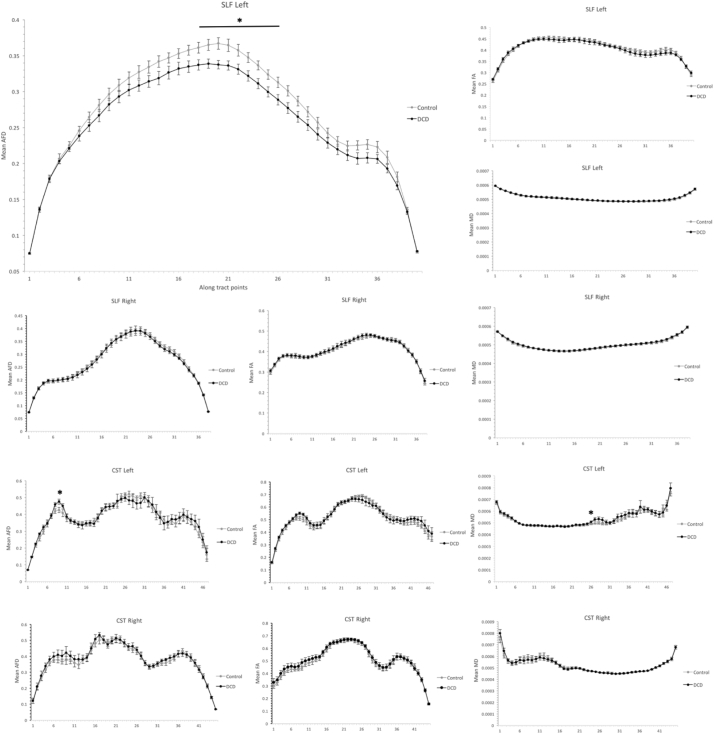
Along tract values for CSD modelled SLF and CST tracts, including mean AFD, FA and MD. Error bars reflect standard error. * Represents points where group differences reached statistical significance at p <.05 uncorrected. No comparisons survived FDR correction. NOTE: CSD- constrained spherical deconvolution; SLF, superior longitudinal fasciculus; CST, corticospinal tract; AFD, apparent fibre density; FA, fractional anisotropy; MD, Mean Diffusivity.